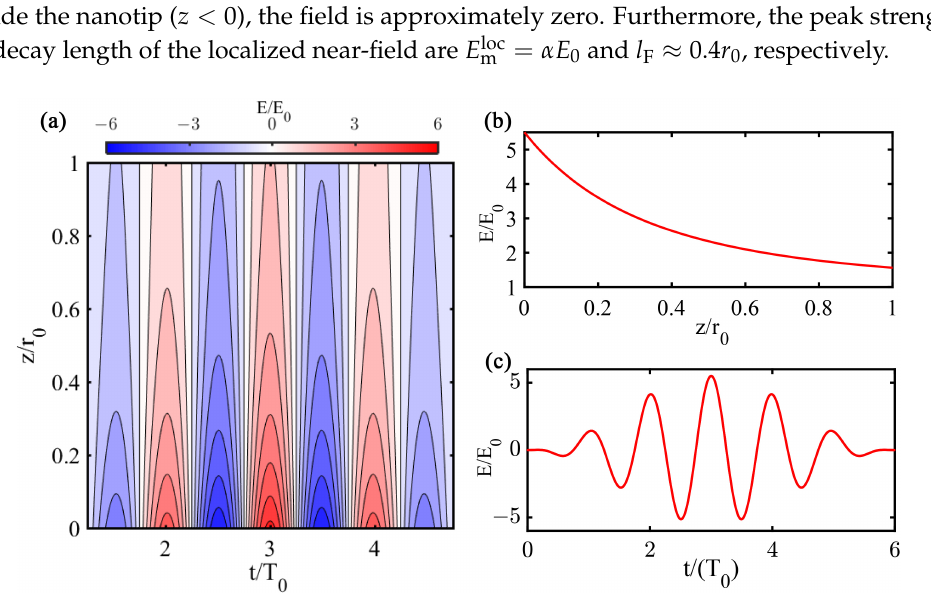
Figure 1. (color online) ( a ) Contour plot of the near-field E ( z , t ) as a function of the emission time and the distance from the nanotip surface. Zero distance ( z = 0) represents the nanotip surface, r 0 is the radius of nanotip, T 0 = 2 π / ω 0 the optical period of the laser electric field and E 0 the peak strength of the incident laser electric field. ( b ) The spatial distribution of the near field at t = 3 T 0 . ( c ) The time profile of the near-field at the nanotip surface ( z = 0)